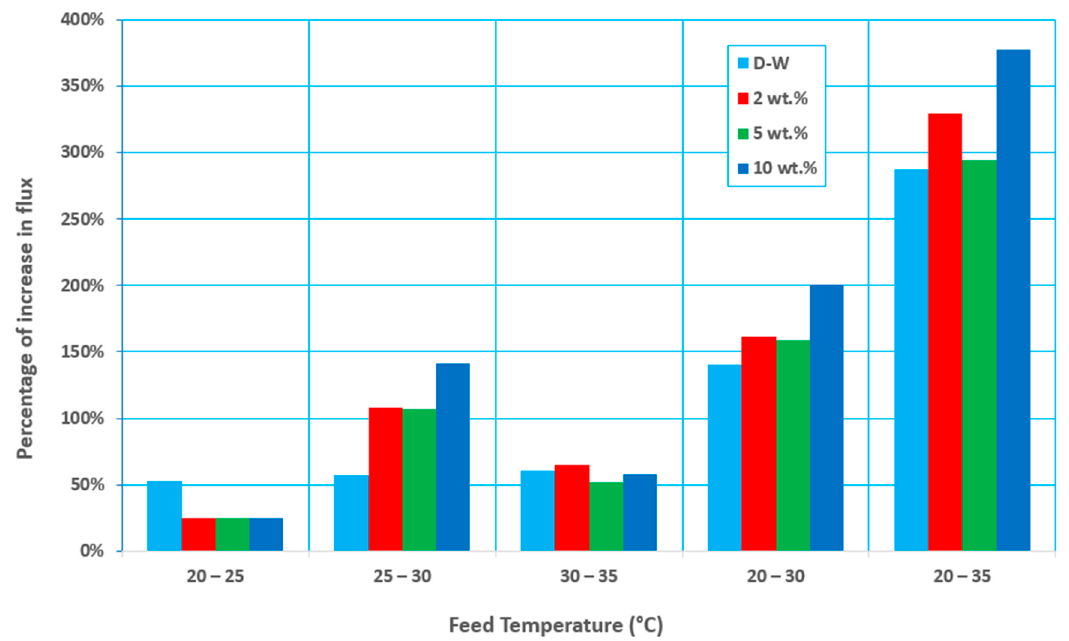
Figure 4. Percentage increase in flux at various temperatures at different concentration factors, a 0.6 L/min feed flow rate, and 60 mmHg (abs) pressure.